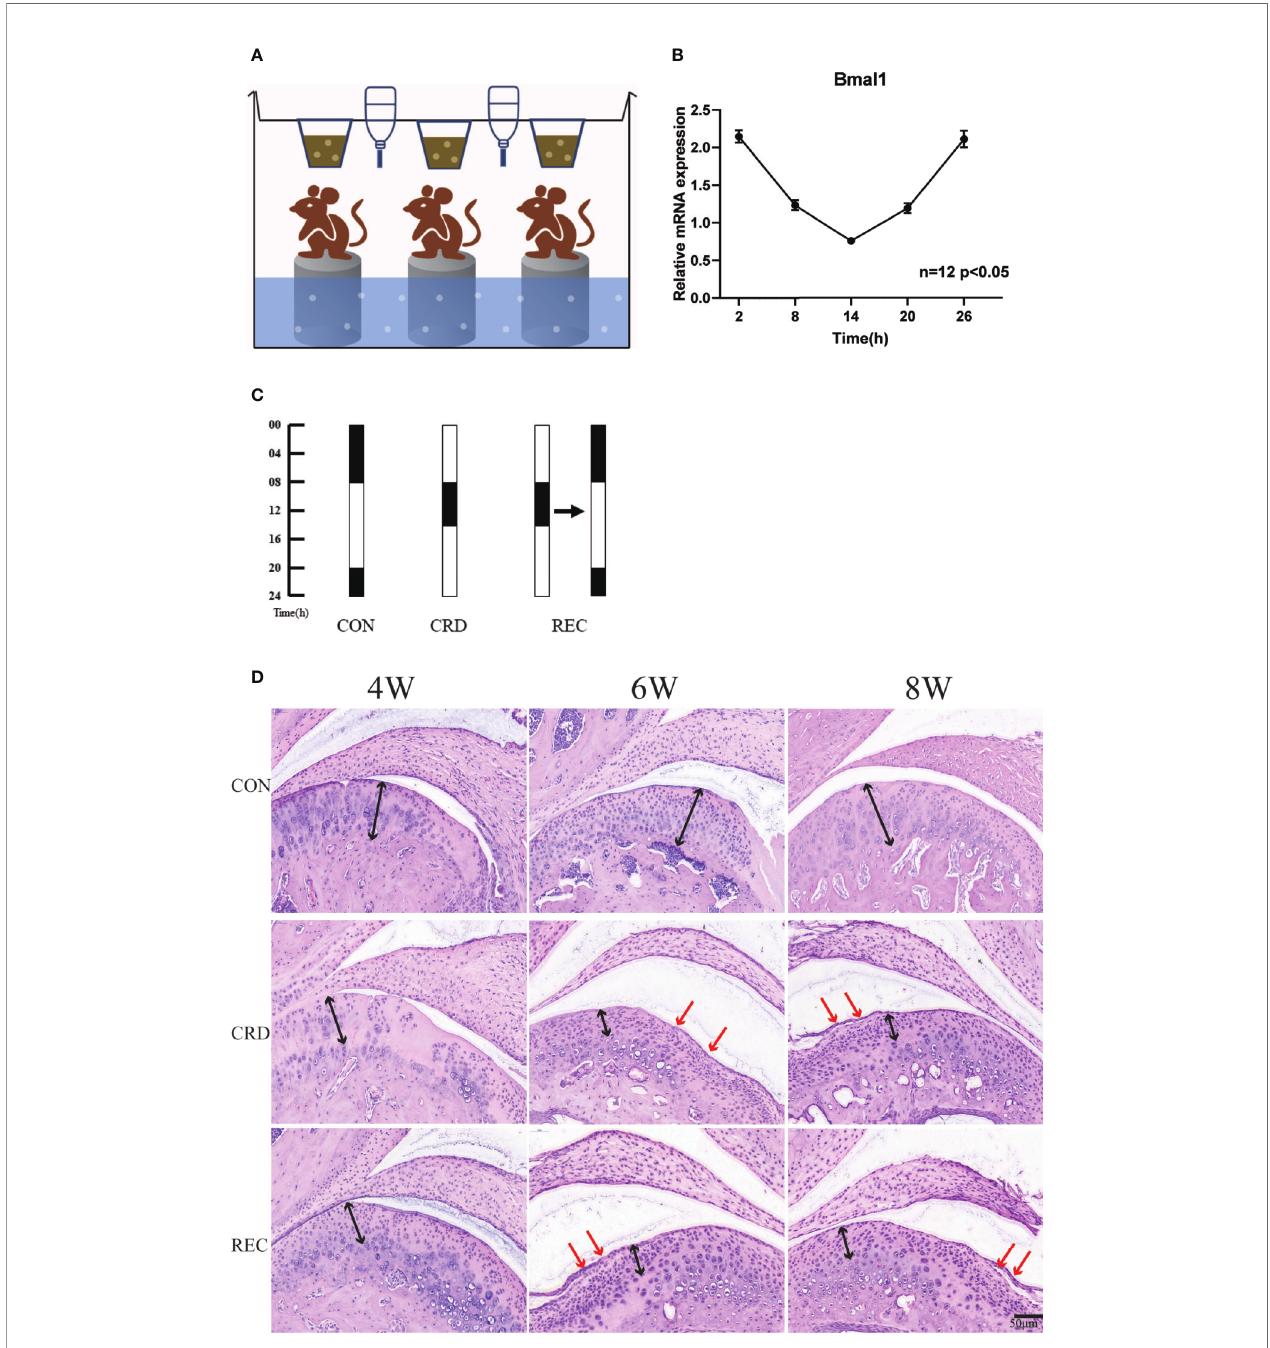
FIGURE 1 | Circadian rhythm disturbance (CRD) induced experimental TMJ-OA in rats. (A) CRD created by a modi fi ed multiplatform method (n=3 rats per group). (B) Circadian expression of bmal1 genes in the spleen. (C) Grouping arrangement and light:dark (LD) cycle arrangement of animal experiments. (D) Rat TMJ sections subjected to hematoxylin and eosin (HE) staining. The black arrows indicate chondrocyte disarrangement, cluster formation and cell-free areas in the CRD and SEC groups. The red arrows indicate cartilage loss and surface integrity reductions. All experiments were performed in triplicate, and the results are expressed as the mean ± SD. The P value is written in the fi gure corner. Scale bar: 50 m recovery group (REC) group, OA-like histopathological ( Figure 1C ). With prolonged sleep deprivation times, we changes, such as irregular cartilage surfaces, cell sequence revealed that some of the 8-week samples had osteophyte-like disorders and cell clusters, were also observed, but they were structures, which proved that OA-like pathological changes milder and less common than those in the CRD group. The gradually increased over time. In the circadian rhythm